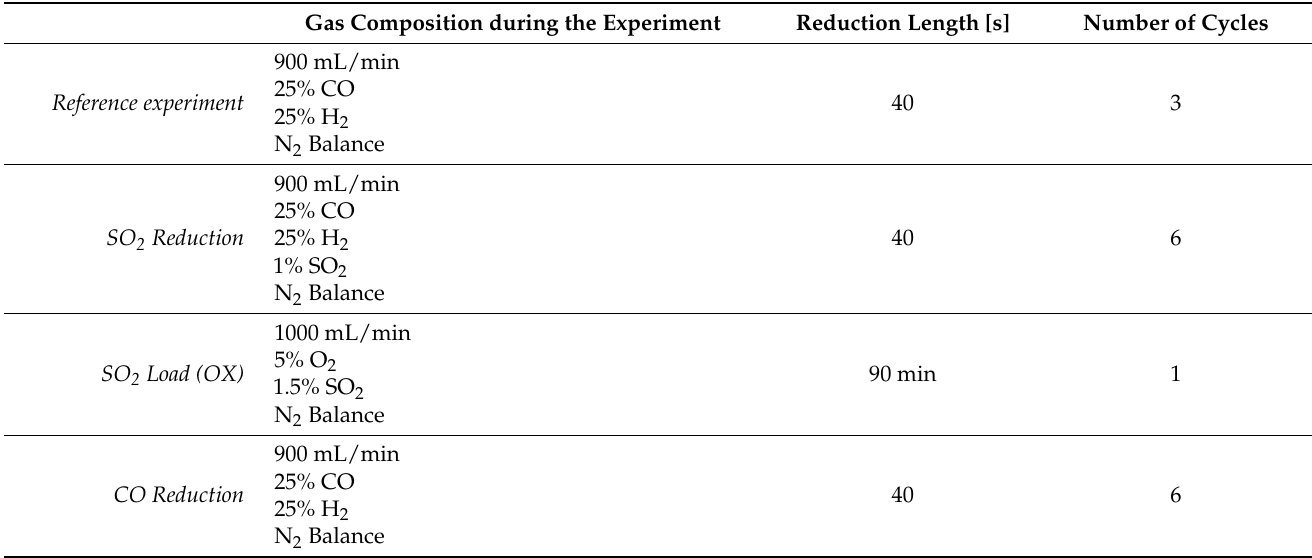
Table 5. Summary of gaseous fuel experiments with syngas for CO conversion evaluation in the same order as execution. Gas Composition during the Experiment Reduction Length [s] Number of